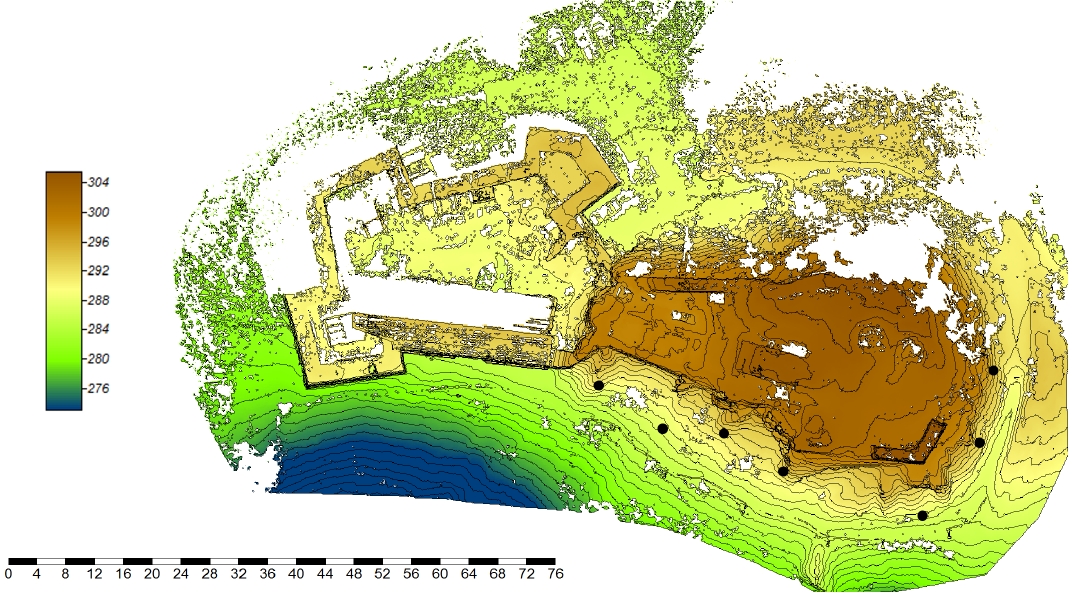
Figure 6. Colour digital surface model with 1m contour line interval of the study area. The solid black dots show the ground control points, while the red dotted and dashed line represents zones affected by